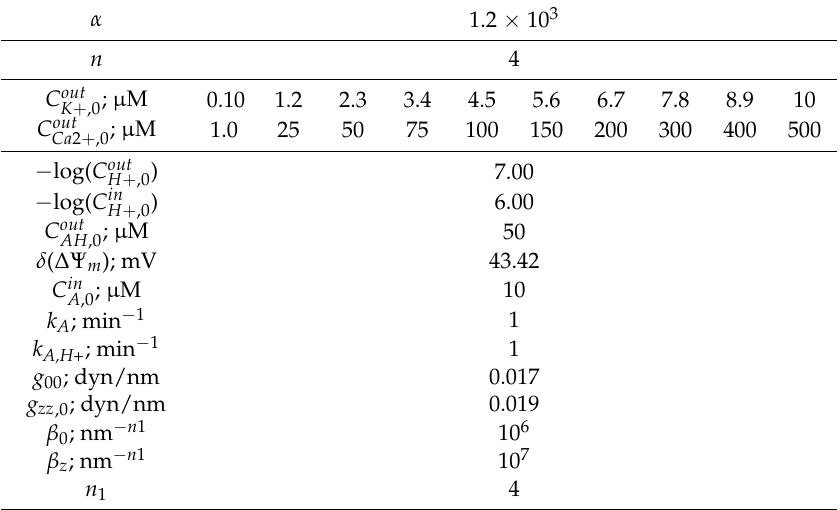
Table 2. Values of the input